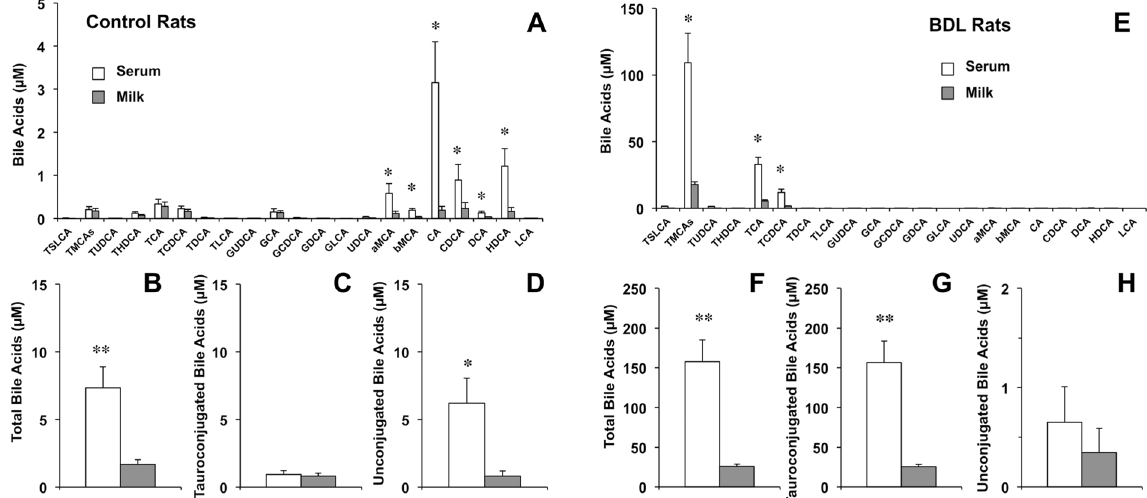
Figure 1. Bile acid concentrations as determined by HPLC-MS/MS in paired samples of serum and milk collected on day 10 after delivery from healthy lactating rats (n = 6) ( A – D ) or rats with bile-duct ligation (BDL) from day 14 of pregnancy (n = 6) ( E – H ). Values (means ± SEM) are expressed as individual bile acid species ( A , E ), total bile acids ( B , F ), taurine-conjugated bile acids ( C , G ) and unconjugated bile acids ( D , H ). * p < 0.05, ** p < 0.01, comparing serum and milk by the paired t